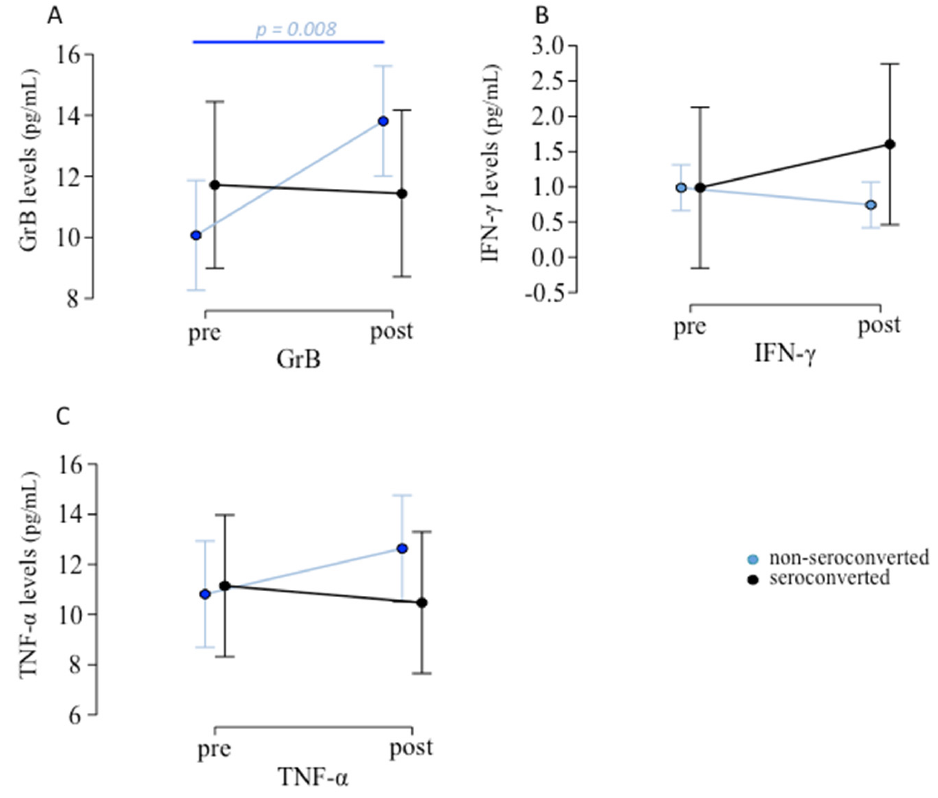
Figure 3. Inflammatory mediators’ levels pre- and post-vaccination in o-pwMS. ( A ) Among the